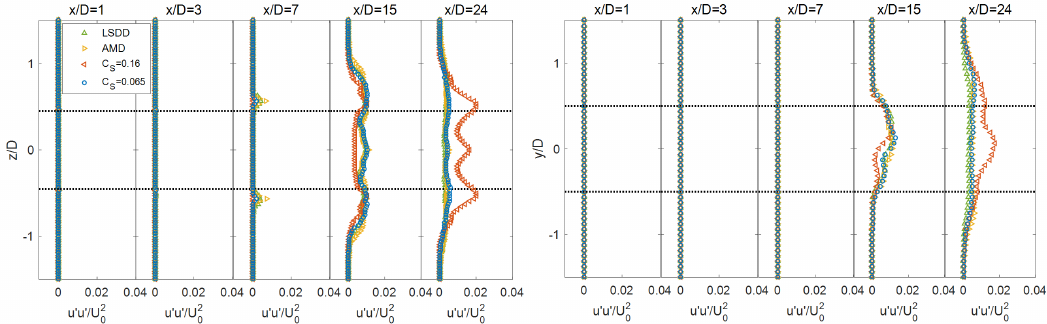
Figure 5. Contours of the normalized streamwise velocity variance ( u (cid:48) u (cid:48) / U 2 plane ( left ) and in the central horizontal x − y plane ( right ) for different SGS models: (from top to the bottom) LSDD model, AMD model, SMAG model with C S = 0.16, and SMAG model with C S = 0.065.